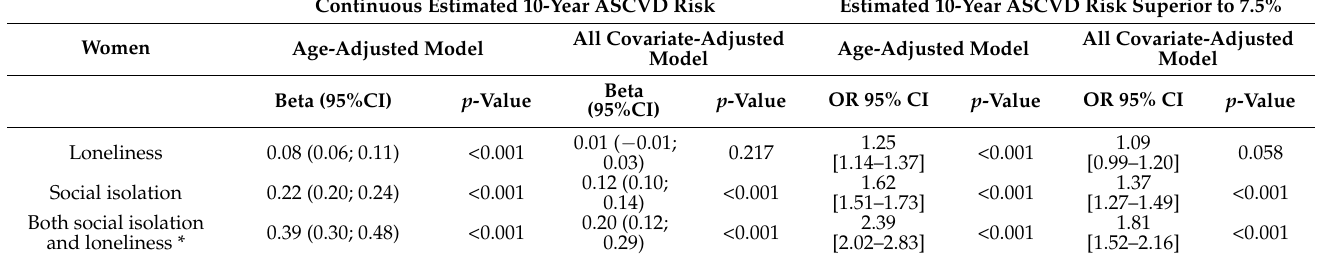
Table 3. Multiple linear and logistic regression models for estimated 10-year ASCVD risk among women (all covariates adjusted: age, education, income level, physical activity, couple, antidepressant medication, Townsend deprivation index, BMI, triglycerides, and CKD). The reference was the reference